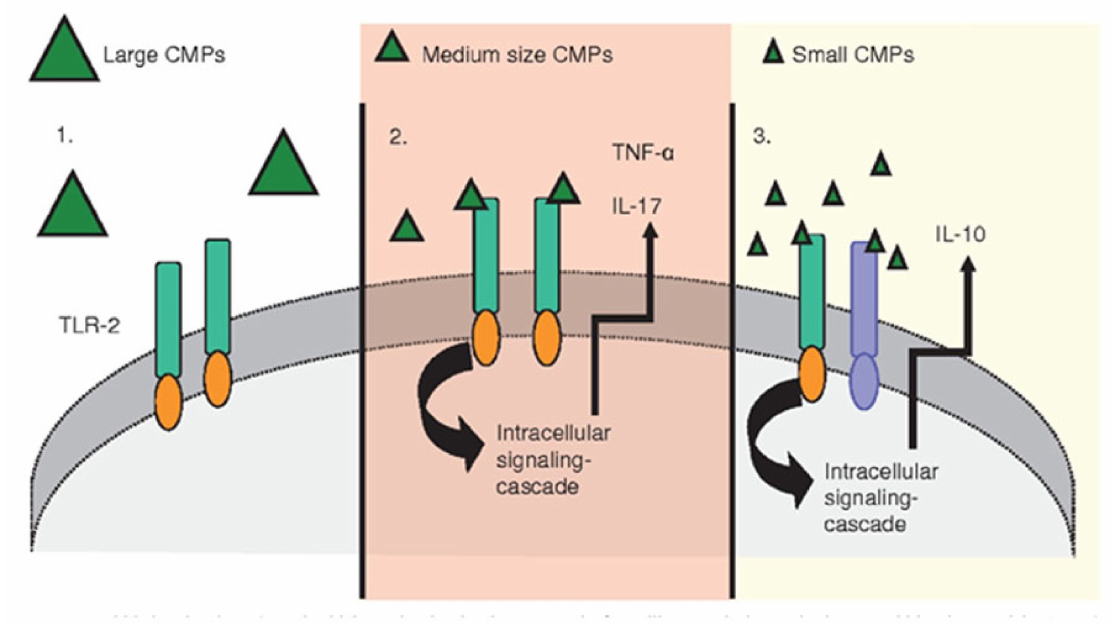
Figure 4. The pro-inflammatory or anti-inflammatory activity of chitin depends on its size (by the courtesy of Reference [43]).